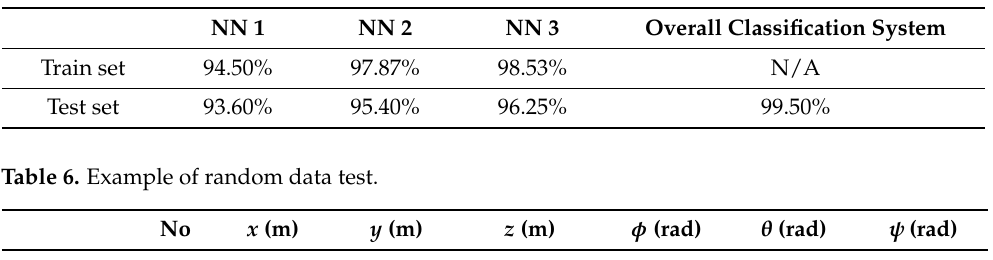
Table 5. Performance of the classification system.